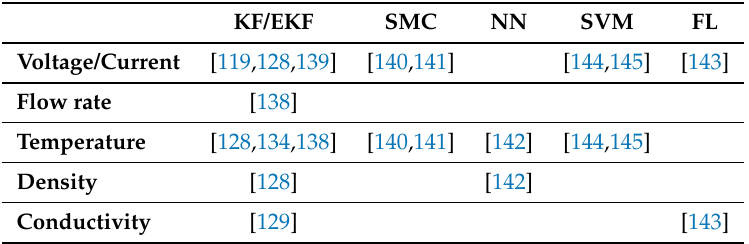
Summary of SOC observers with their measurement variables (KF: Kalman